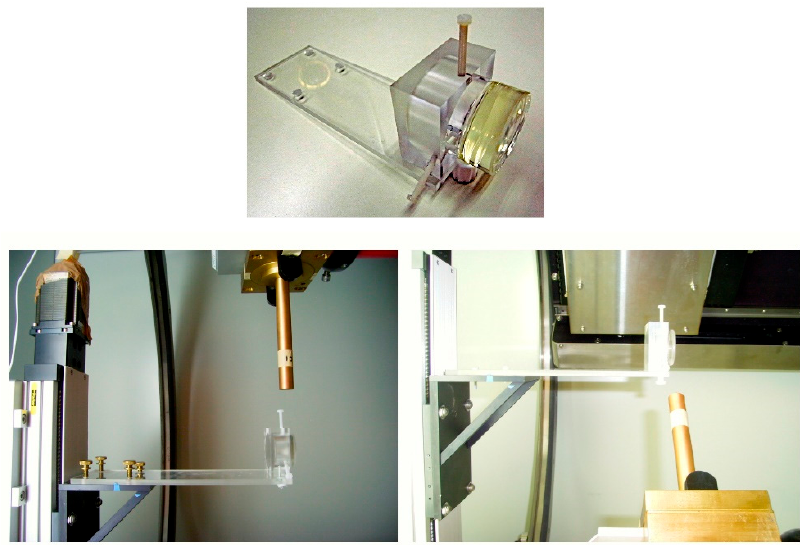
Figure 9. Upper : the PMMA RFG cell holder with a 20 mm thick RFG gel in a 50 mm diameter quarts cell for measurements in a “small animal” microbeam X-ray irradiation facility at the Antonie van Leeuwenhoek Ziekenhuis (Nederlands Cancer Institute) Amsterdam. Lower : a 6 mm gel positioned under the beam collimator, which could be rotated over 360 degrees in the X/Y plane.